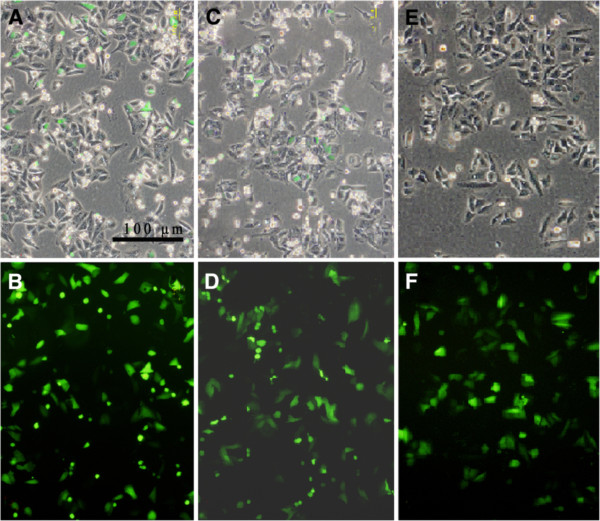
SATB1-siRNA induced morphology changes of NCI-H446 cells 48 hours after transfected: A, B,transfected with SATB1- SiRNA-1(X100); C, D: transfected with SATB1- SiRNA-2(X100); E, F: transfected with SATB1- siRNA-N (X100).